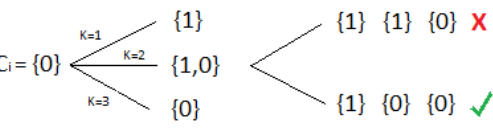
Figure 2: Instance which is not removed because some of its neigbors are